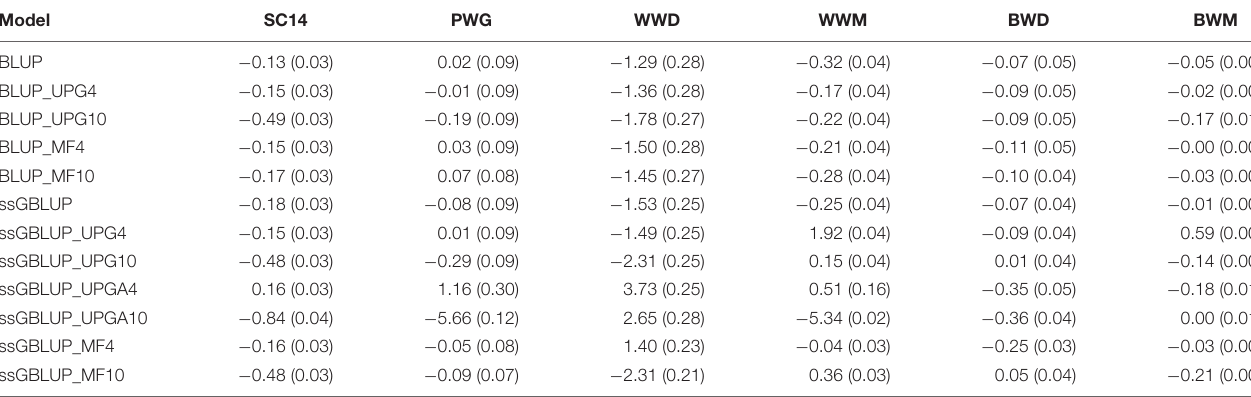
TABLE 6 | Biases and standard errors of (G)EBV estimated as differences between direct and maternal mean (G)EBV from reduced and complete datasets using various models with and without genetic groups. Model SC14